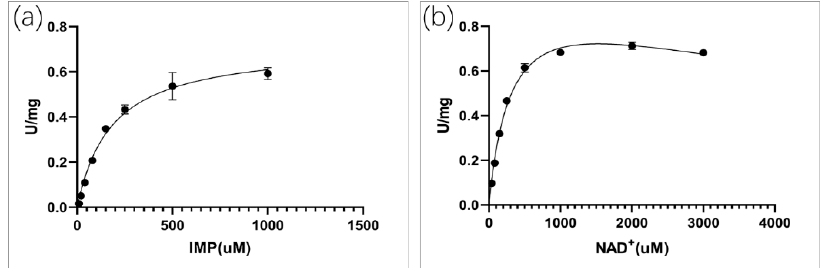
Figure 4. Enzyme activity of C Las IMPDH Δ 98 ‐ 201. ( a ): Varying concentrations of IMP at a fixed concentration of NAD + (2 mM); ( b ): Varying concentrations of NAD + at a fixed concentration of IMP (1 mM).